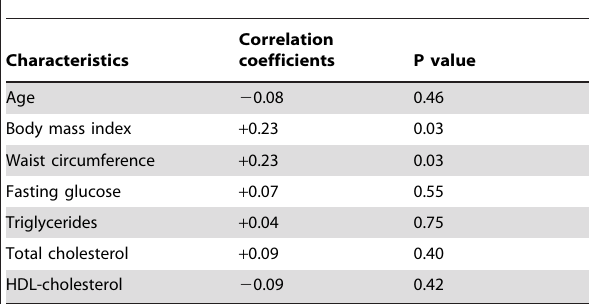
Table 2. Correlation coefficients between levels of Methanobacteriales with obesity and obesity-related metabolic variables